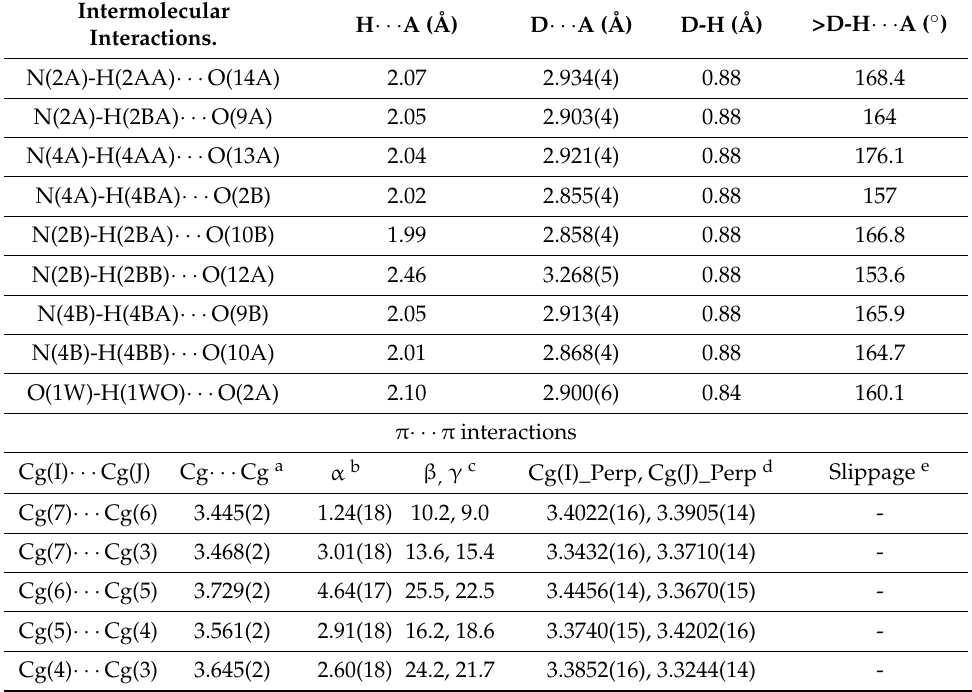
Table 3. Intermolecular interactions in 2 .